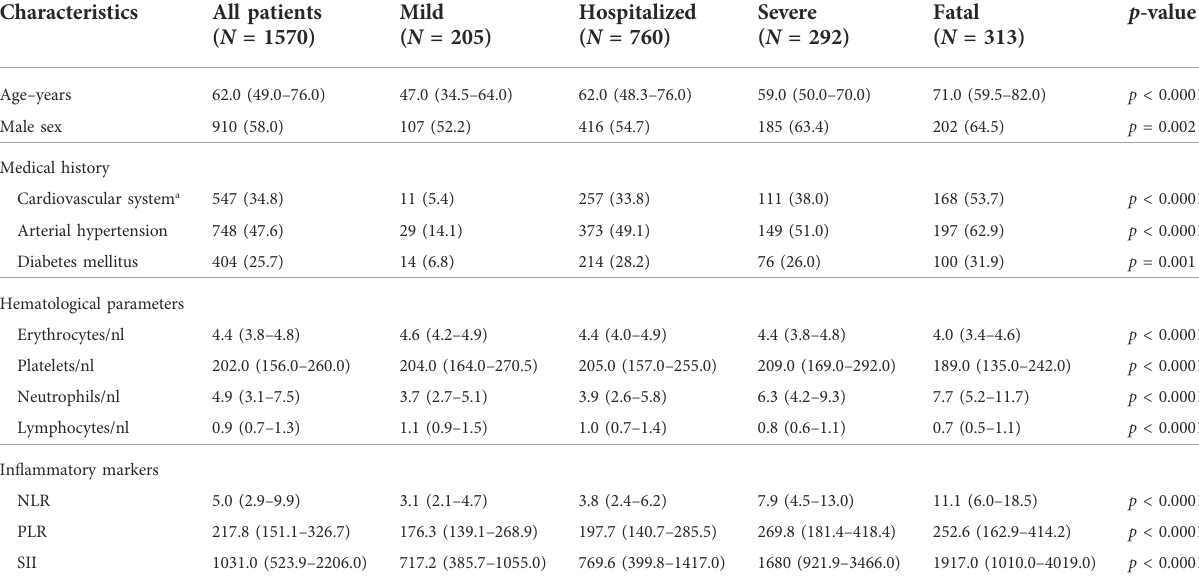
TABLE 1Demographics,clinicalcharacteristics,andoutcomeofthe disease inSARS-CoV-2-positive patients.Classi fi cationaccordingtothe COVID- 19surveillancereportoftheECDC:category “ mild ” isacasethathasnotbeenreportedashospitalizedordead.A “ severe ” casehasbeenadmitted to intensive care and/or required mechanical respiratory support. All values are given in medians and interquartile ranges (IQR), except from sex and medical history, which are reported in absolute counts and percentages.